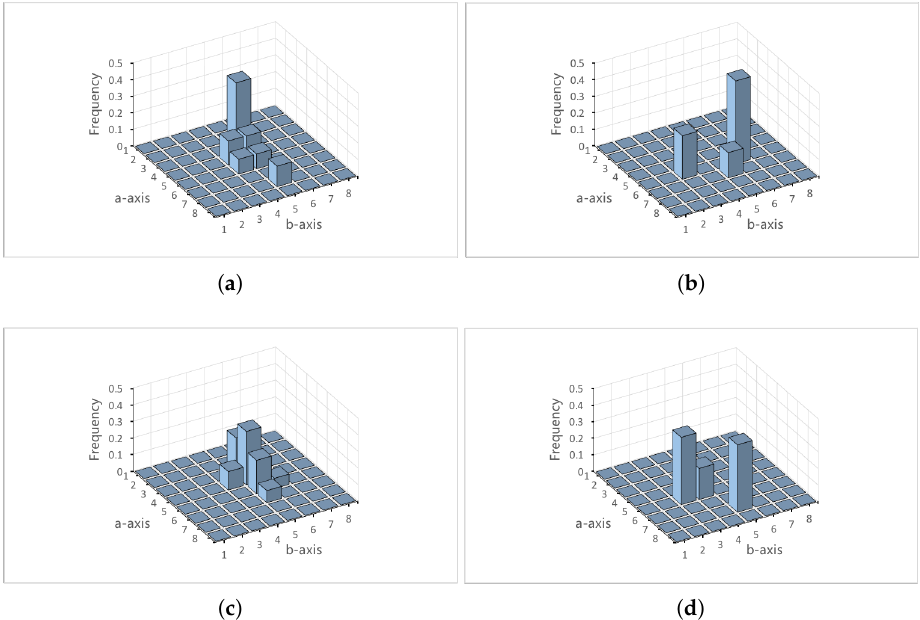
Figure 5. Apparent and absent color histograms. ( a ) P D for image A. ( b ) P N for image A ( c ) Q D for image B. ( d ) Q N for image